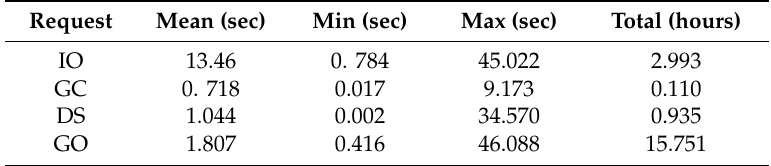
Table 19. Database queries time statistics, registered in test case B and 500 concurrent users,